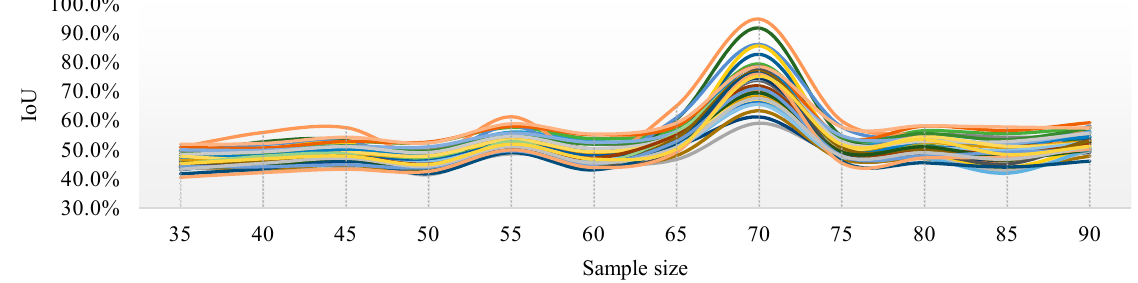
Figure 11. IoU curves of 40 test images with different sampling sizes when the threshold level T = 5.